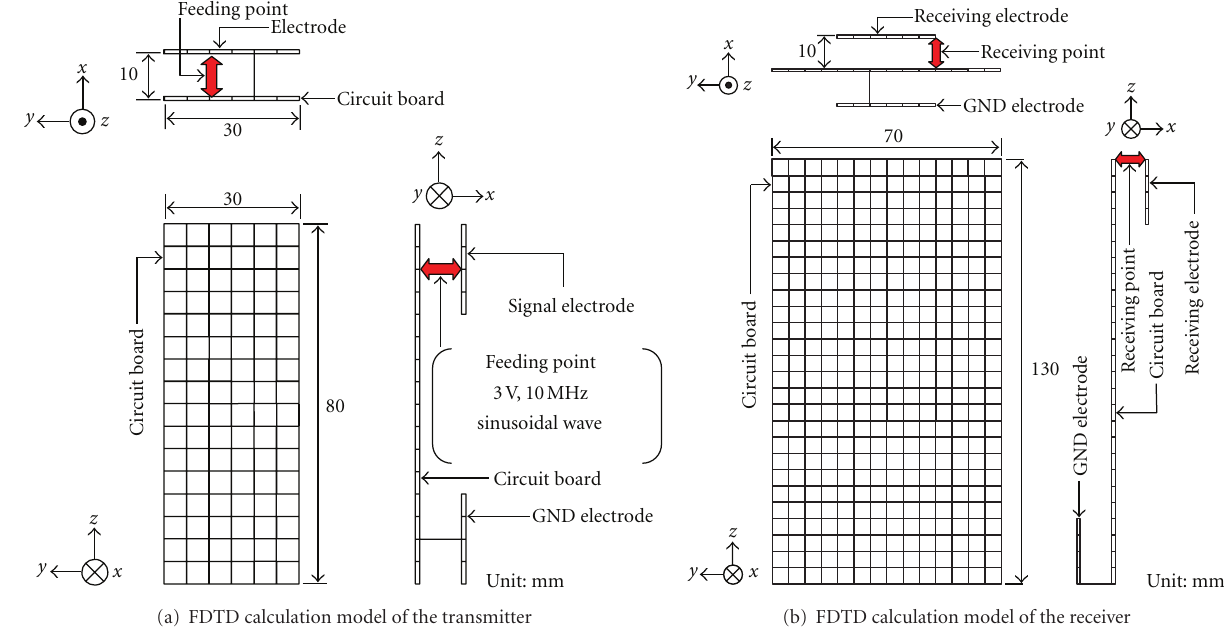
Figure 8: FDTD calculation model of the transmitter and receiver.